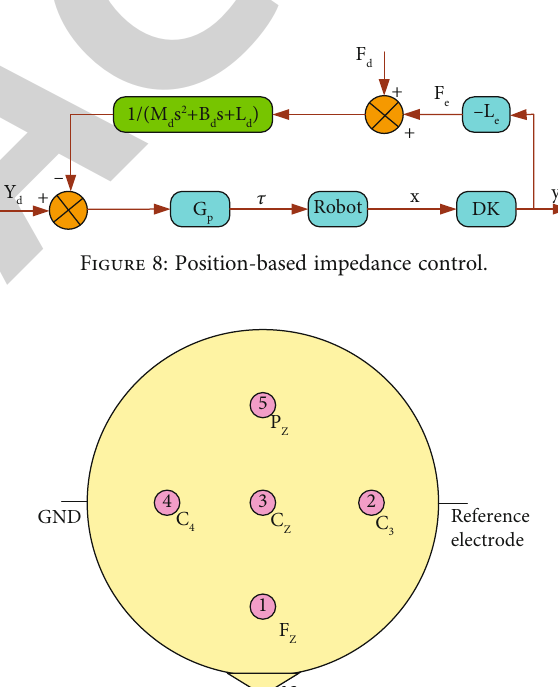
Figure 7: Force-based impedance control.